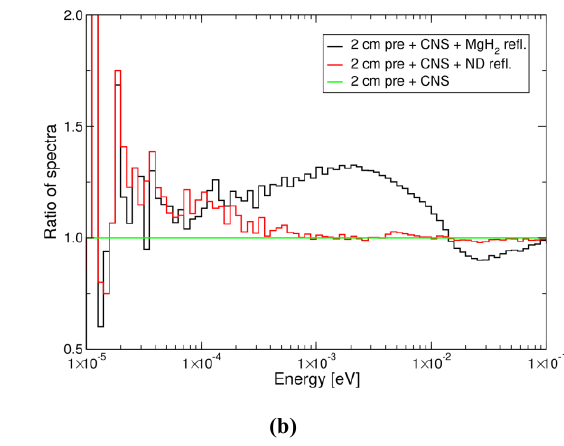
Fig.13 : Spectra of the outgoing neutron current from the cold neutron source model (a). Ratio of the spectra, using as reference the case with premoderator and without cold neutron reflector